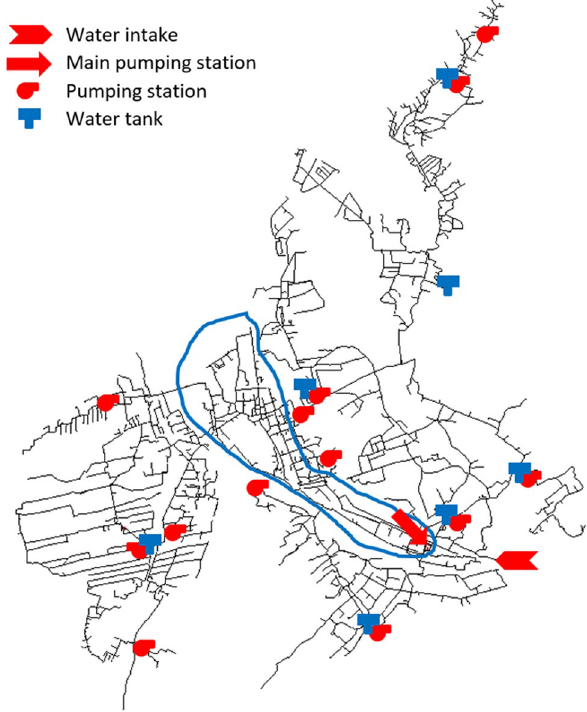
Fig. 1 Scheme showing the geometric structure of the water supply network along with the location of the intake, pumping station, and water tanks. The blue line designates the analyzed